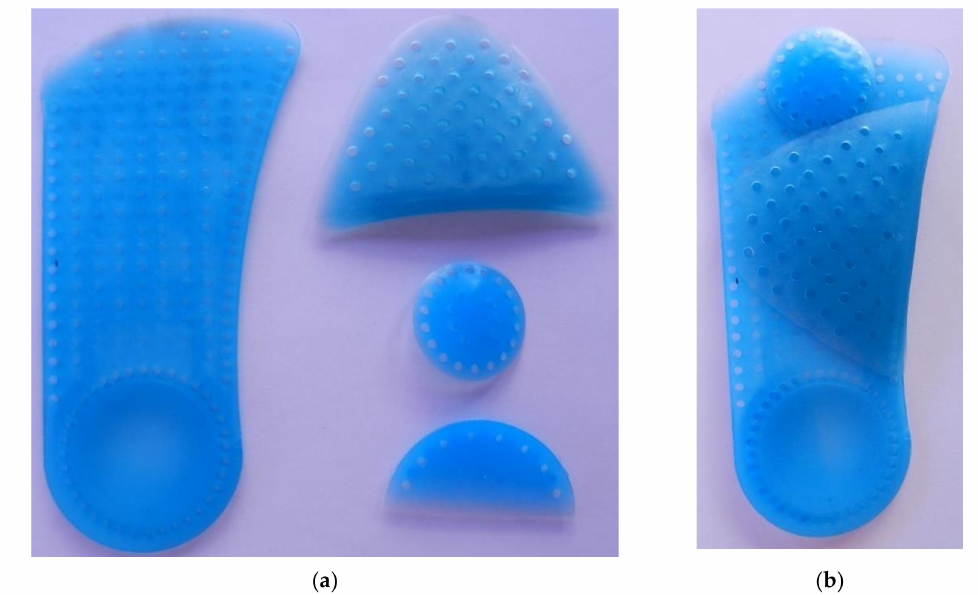
Figure 7. ( a ). Manufactured components or modules, ( b ). Assembled components or modules.